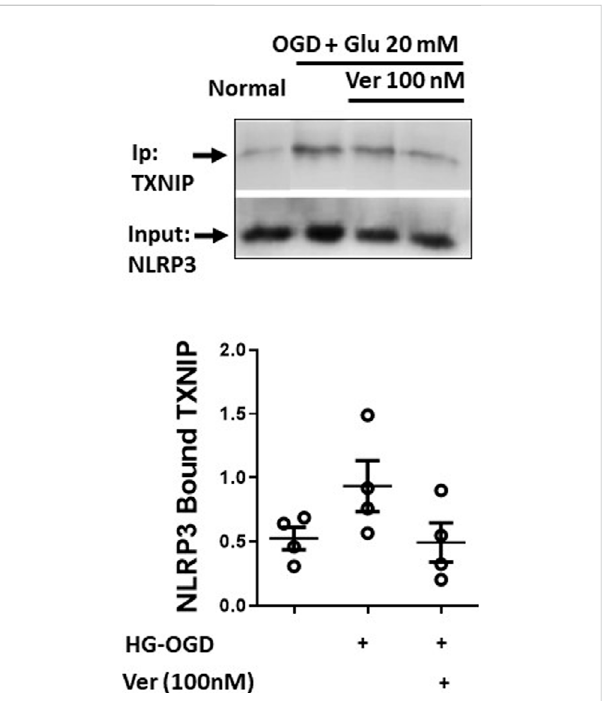
FIGURE 2 Verapamil marginally reduces TXNIP binding to NLRP3 in fl ammasome in OGD-HGr. PCN cultures were exposed to OGD and incubated in normal conditions with glucose concentration of 20 mM in medium for 24 h. OGD-HGr PCN cultures were treated with verapamil in 0 and 100 nM concentration. TXNIP in PCN cellsextractswereimmunoprecipitatedwithNLRP3-speci fi cantibody using magnet beads. The samples were then immunoblotted for the precipitated TXNIP and the NLRP3 as the input molecule. TXNIP, thioredoxin-interacting protein; NLRP3, NOD-like receptor protein 3; PCN, primary neural cells; HGr, hyperglycemic reperfusion; OGD, oxygen-glucose deprivation; ip., immunoprecipitated. All values are presented as mean ± SEM ( n = 4/group); * p <